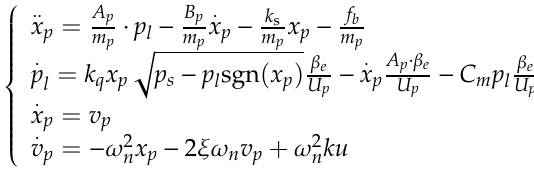
Figure 4. Schematic diagram of servo valve control cylinder of experimental platform.